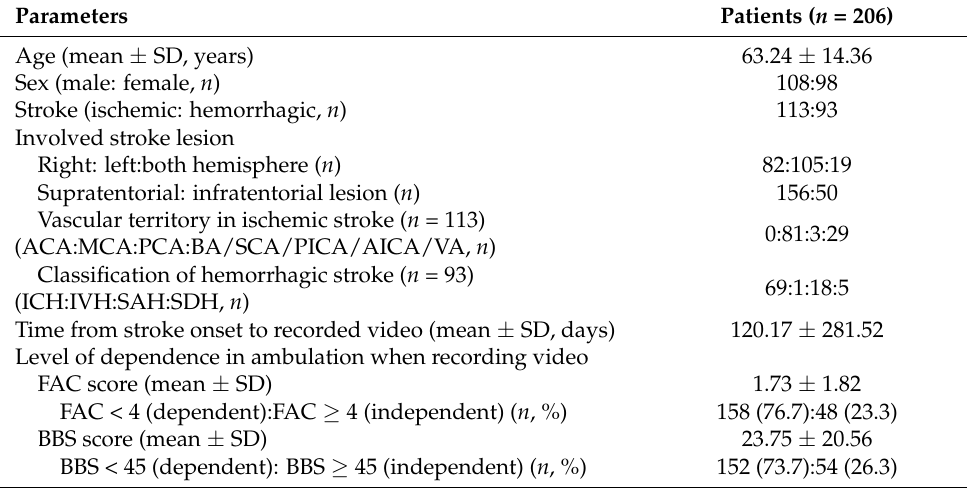
Table 1. Demographic and clinical characteristics of stroke patients.